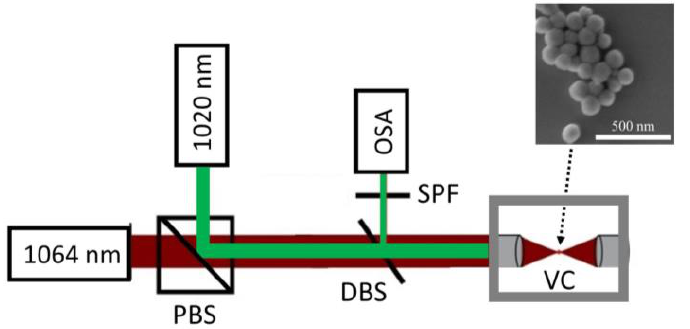
Figure 12. Laser trapping and cooling Yb 3+ :NaYF nanocrystals. A 1064 nm laser was used for the optical-dipole-trapping of Yb 3+ :NaYF nanocrystals in a vacuum chamber. A 1020 nm laser was used for anti-Stokes laser-cooling of Yb 3+ :NaYF nanocrystals. PBS: Polarizing Beam Splitter, DBS: Dichroic Beam Splitter, SPF: Short-Pass Filter, OSA: Optical Spectrum Analyzer.